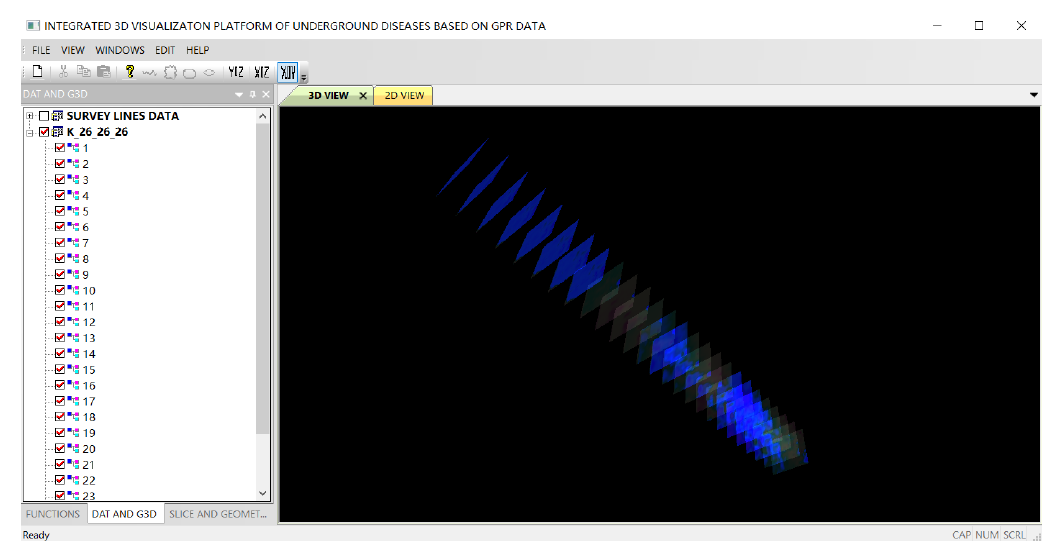
Figure 9. Parameters configuration.